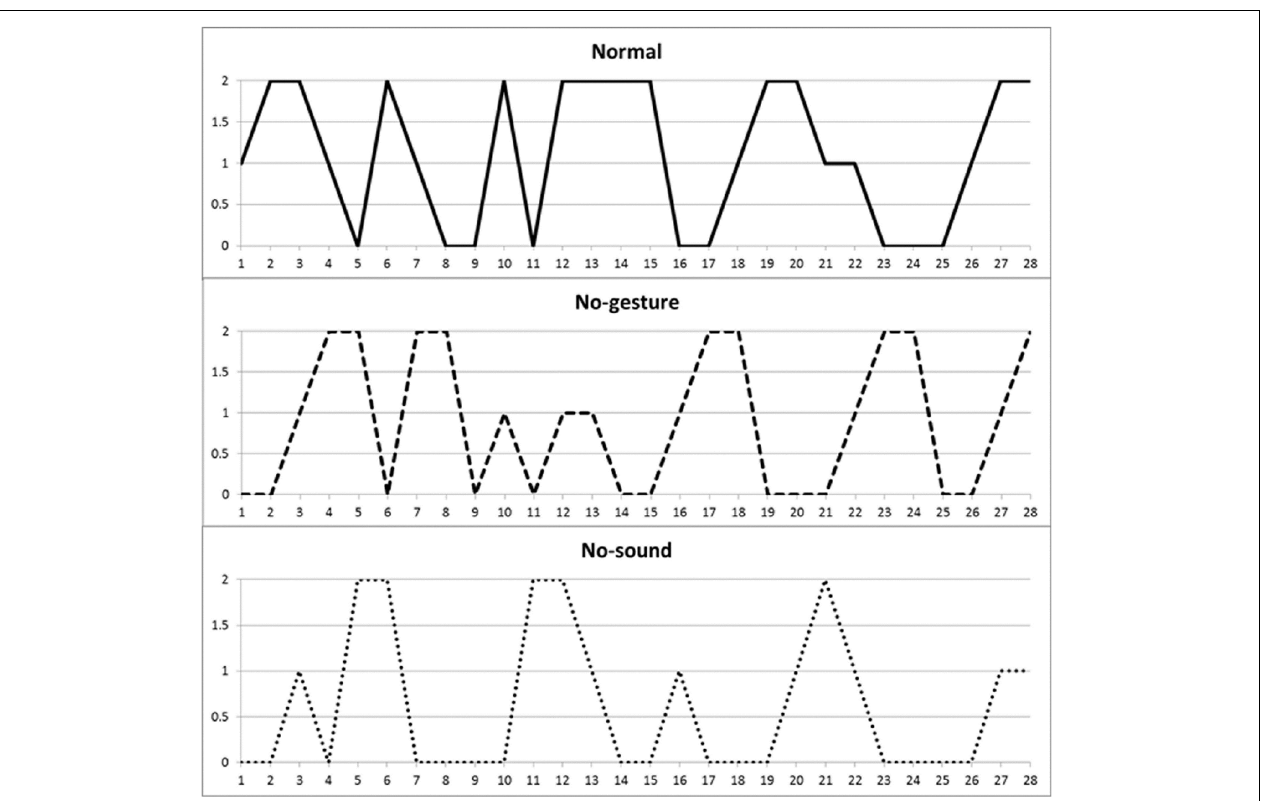
FIGURE 1 | Individual Limbs Movements of R. playing Row Row the Boat in the three conditions. The order of condition presented was normal, no-gesture, and no-sound. A score of 2 indicates that movements of both the